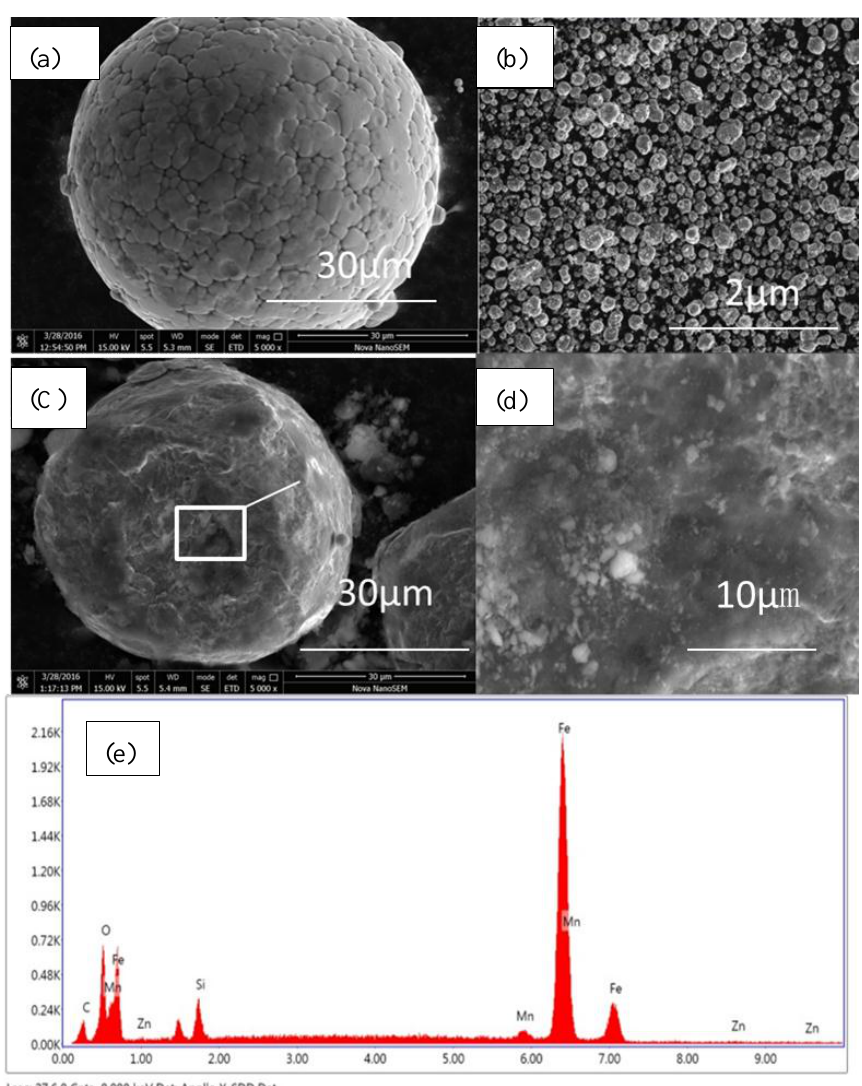
Figure 3. SEM images of ( a ) the raw Fe-Si powders; ( b ) MnZn(Fe 2 O 4 ) 2 powders; ( c ) the Fe-Si/MnZn(Fe 2 O 4 ) 2 composite powders; ( d ) the magnified image for the selected region in ( c ) and (e)EDS spectrum for the selected region in ( c ).